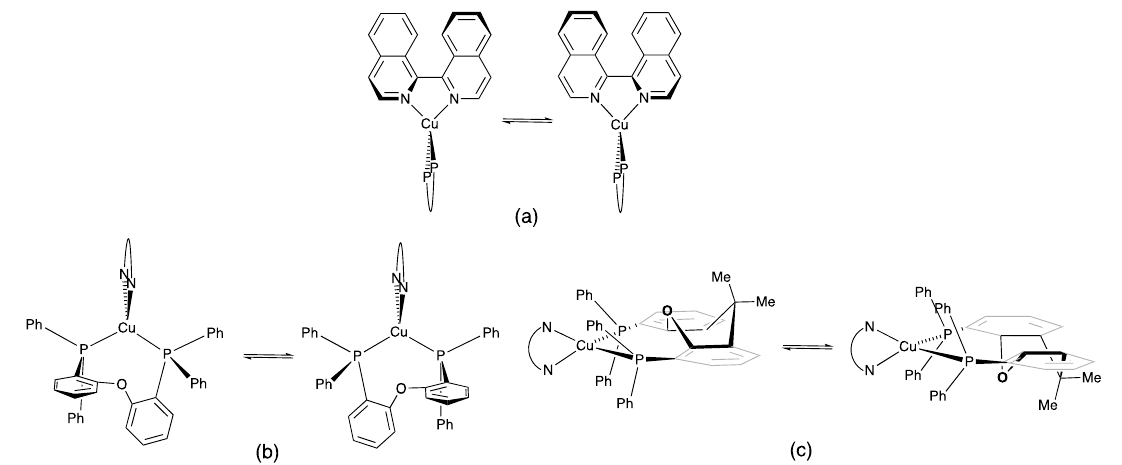
Figure 6. EXSY peaks in the NOESY spectrum (500 MHz, C 2 D 2 Cl 4 , 328 K) of [Cu(xantphos)(biq)][PF 6 ] between resonances for pairs of phenyl protons. 3.3. Photophysical and Electrochemical Properties The absorption spectra of [Cu(POP)(biq)][PF 6 ] and [Cu(xantphos)(biq)][PF 6 ] in CH 2 Cl 2 solutions are shown in Figure 7 (red plots) and are compared with those of [Cu(POP)(bq)][PF 6 ] and [Cu(xantphos)(bq)][PF 6 ] (black curves). The absorption maxima are given in Table 2. Absorptions below 380 nm are assigned to ligand-based π*  π tran- sitions, while the broad bands in the visible region arise from MLCT from copper to π* orbitals on the diimine ligand. The spectra for the 2,2'-biquinoline-containing compounds are in agreement with those previously published [15,17,18]. Figure 7 illustrates that in- corporation of the bq ligand leads to a shift in the MLCT absorption to lower energies than that observed for [Cu(POP)(biq)][PF 6 ] and [Cu(xantphos)(biq)][PF 6 ]. This is rationalized in terms of the ring fusion in bq (Scheme 1) being adjacent to the N atoms but remote from the N atoms in biq (Scheme 2). An expansion of the MLCT regions is displayed in Figure S9. Excitation [Cu(POP)(biq)][PF 6 ] and [Cu(xantphos)(biq)][PF 6 ] at wavelengths between 365 nm and 420 nm does not lead to an emission, and in the solid state, very weak emissions (PLQY < 1%) with λ maxem = 650 nm